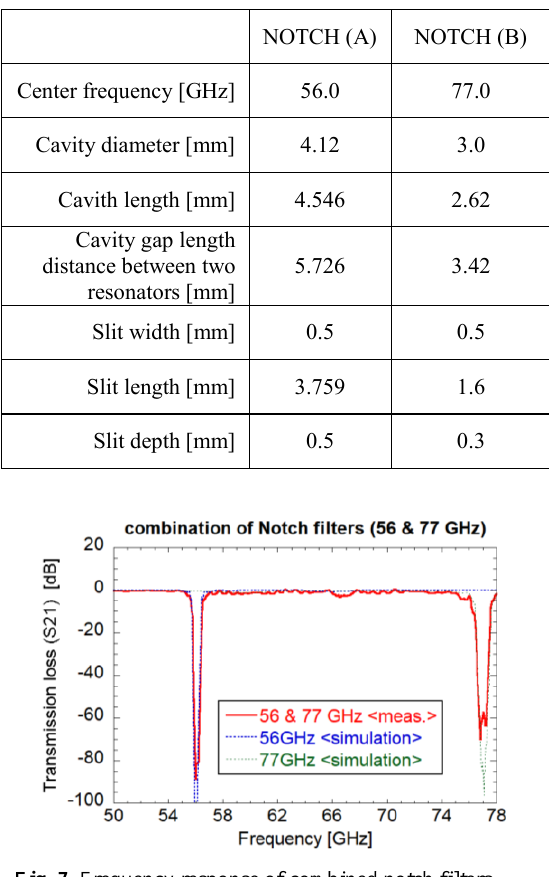
Fig. 7. Frequency response of combined notch filters.